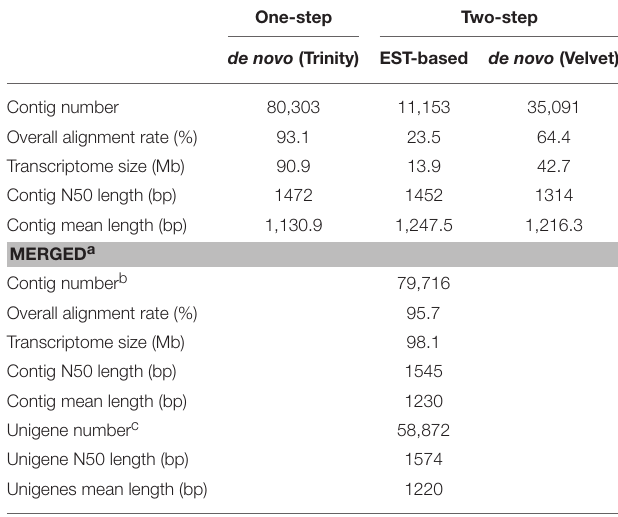
TABLE 2 | C. intybus RNA sequencing datasets. TABLE 3 | Features of assembled